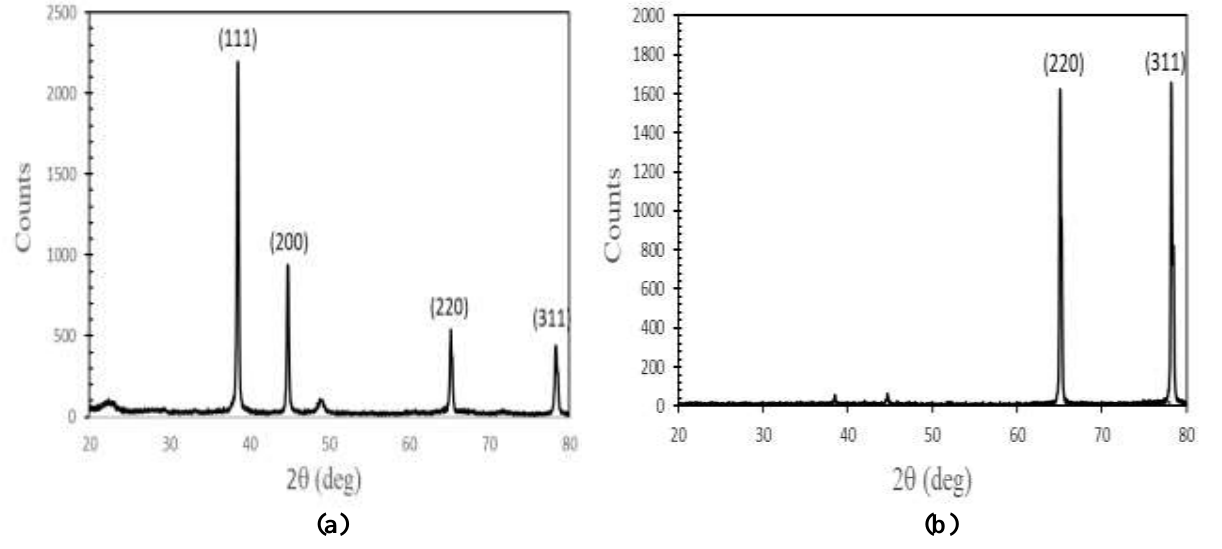
Figure 3: ( a) The XRD patterns of Al NPs. (b): XRD patterns of Aluminum